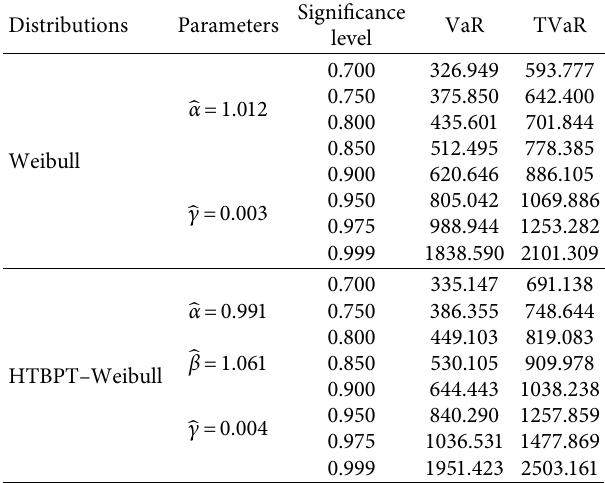
Figure 15: The QQ and box plots of the vehicle insurance loss data. Table 8: Results for the actuarial measures using the vehicle in- surance loss